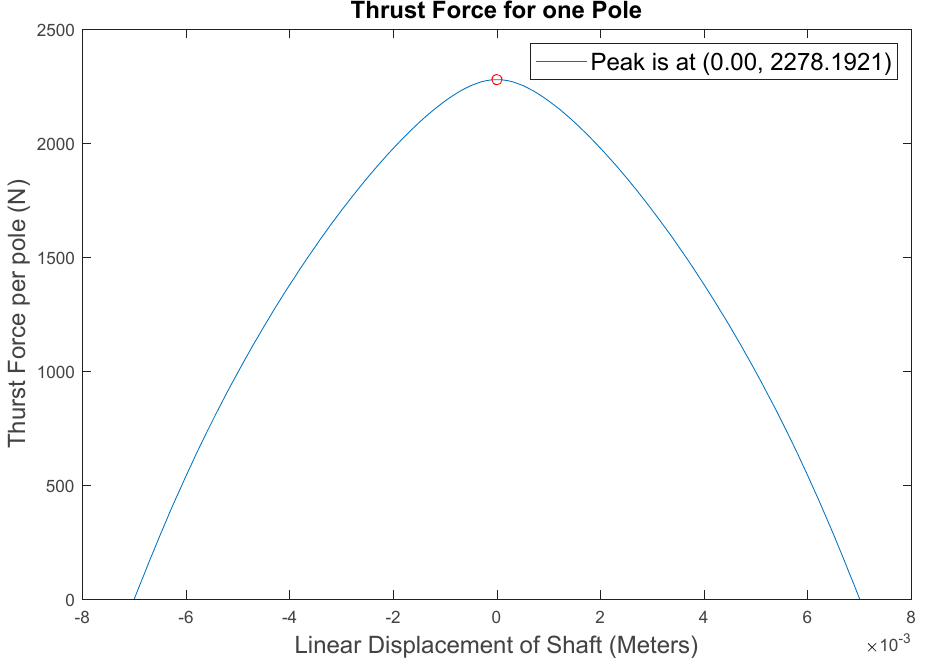
Figure 15. Axial flux density as a function of axial distance—Calculated using (18a).